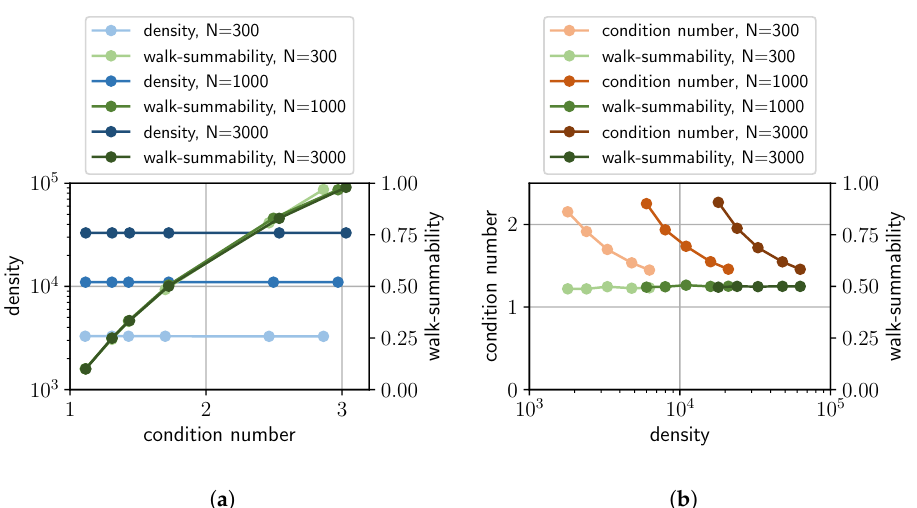
Figure 9. The two plots illustrate the main properties of the matrices in the LESs-set with constant density in ( a ) and the LESs-set with constant condition number in ( b ). Both sets contain LESs with dimensions 300, 1000, and 3000. For each dimension the set in ( a ) contains 6 LESs and in ( b ) 5 LESs. Each dot corresponds to one